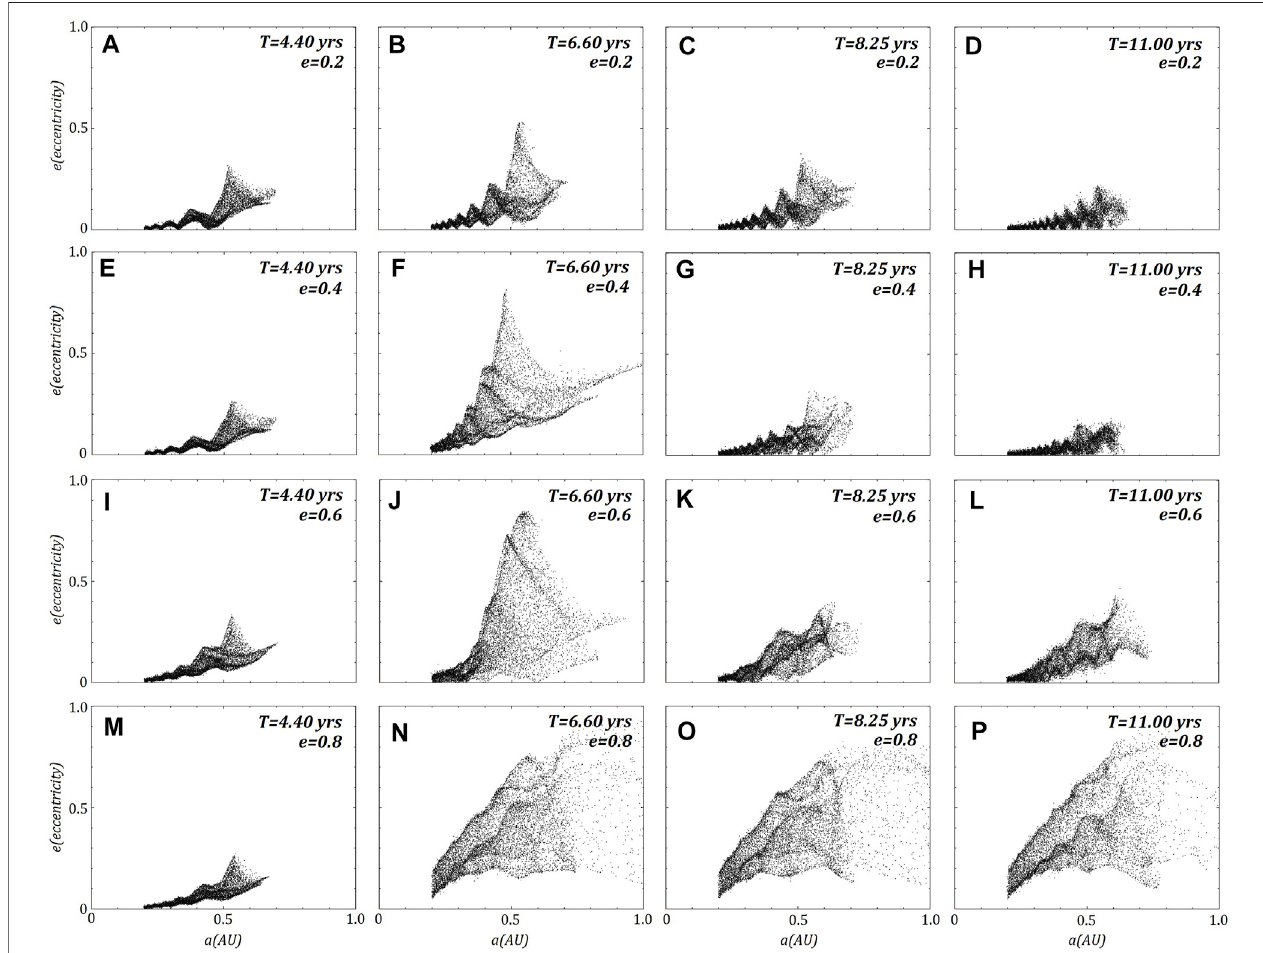
FIGURE 11 | The same four retrograde ring models shown in Figure 2 . Here the calculated eccentricities and semi-major axis for all ring particles are plotted. The rows represent each model, where e (cid:1) 0 . 2 (A – D) , e (cid:1) 0 . 4 (E – H) , e (cid:1) 0 . 6 (I – L) and e (cid:1) 0 . 8 (M – P) , while the column represents a snapshot in time at T (cid:1) 4 . 40 yrs ( A , E , I & M ) , T (cid:1) 6 . 60 yrs ( B , F , J & N ) , T (cid:1) 8 . 25 yrs ( C , G , K & O ) , T (cid:1) 11 . 00 yrs ( D , H , L & P ) , where all models began at